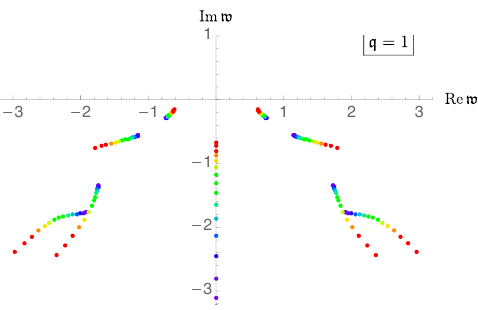
Figure 2. The eight lowest complex quasi- normal modes and the lowest purely imagi- nary one in the spin 0 channel, at q = 1. Ev- ery colorful path-like set of points, starting in purple and ending in red, shows the change of one speci(cid:12)c mode when Q discretely in- creases from 0 to 0 : 8. We have considered 16 regular steps by increments of (cid:1) Q = 0 :